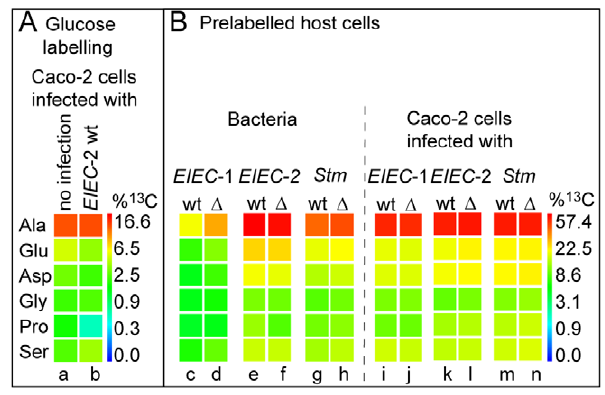
Figure 4. 13 C-Incorporation into amino acids of host cells (Caco-2) and intracellular bacteria (see also Table S5). (A) 13 C- labelled amino acids in Caco-2 cells (not infected) grown in the presence of 10 mM [U- 13 C 6 ]glucose for 6h (lane a) and with infection by EIEC -2 (infection by EIEC -1 led to similar results) (lane b). (B) 13 C-labelled amino acids in Caco-2 cells and bacteria when the Caco-2 cells were grown for 10 generations in the presence of 10 mM [U- 13 C 6 ]glucose and then infected with the bacteria. The data shows the uptake of the 6 labelled host cell amino acids by the three intracellular bacterial wild- type strains (wt) and the corresponding glucose/glucose-6P uptake mutants (indicated as D ) during the 6.5 or 8.5 h period of infection (lanes c-h). Labelled amino acids of the Caco-2 host cells 6.5 or 8.5 h after infection by the wild-type strains (wt) or their glucose/glucose-6P uptake mutants ( D ) (lanes i-n). Colours indicate the amount of 13 C- incorporation (% 13 C) according to a quasi logarithmic scale.